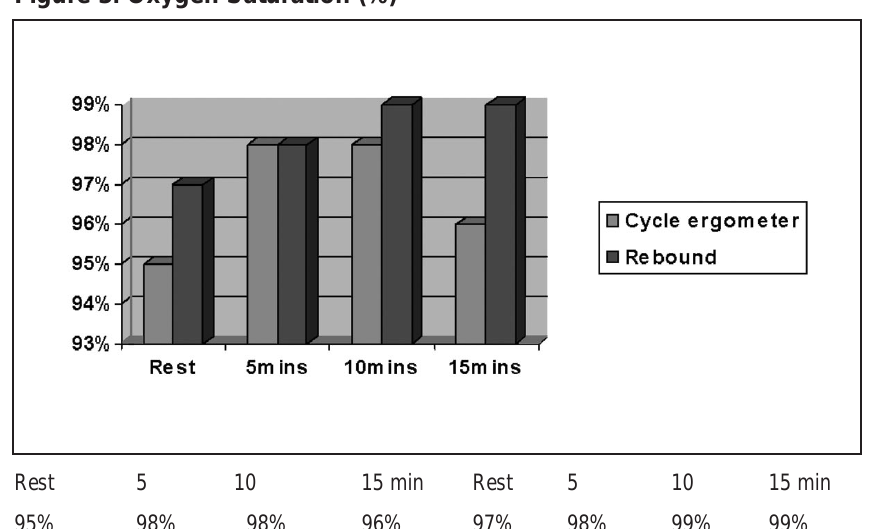
Figure 3: Oxygen Saturation